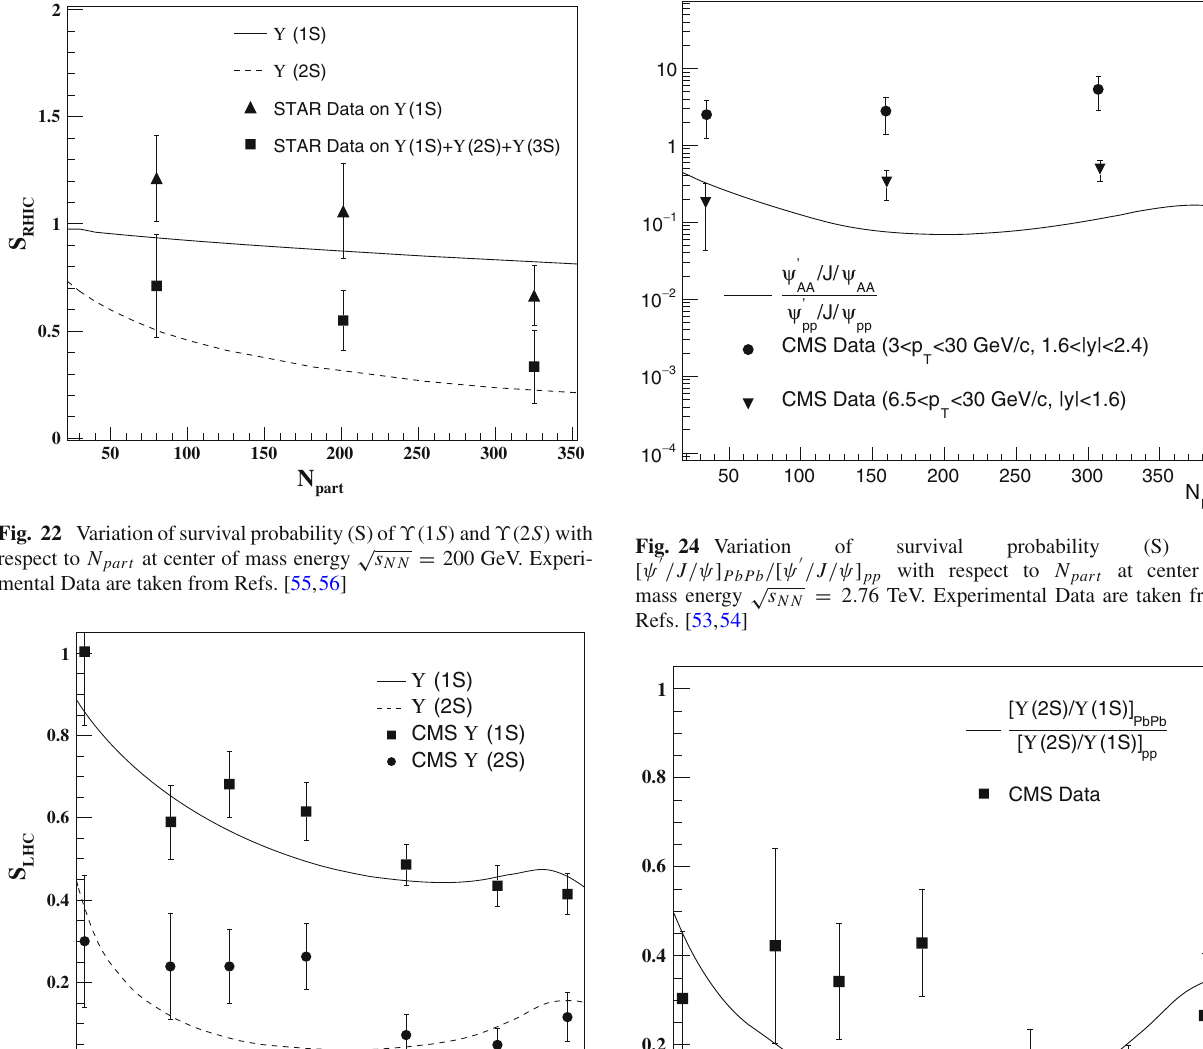
√ s NN = 2 . 76 TeV. Experi-